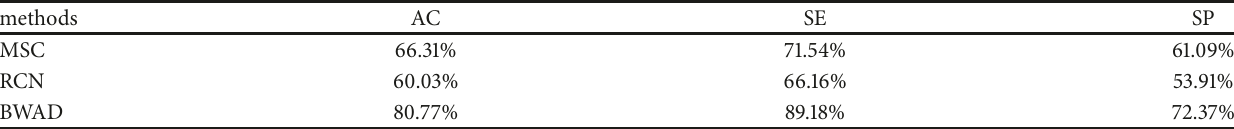
Table 4: Comparison with traditional rate-independent AF detection algorithms.